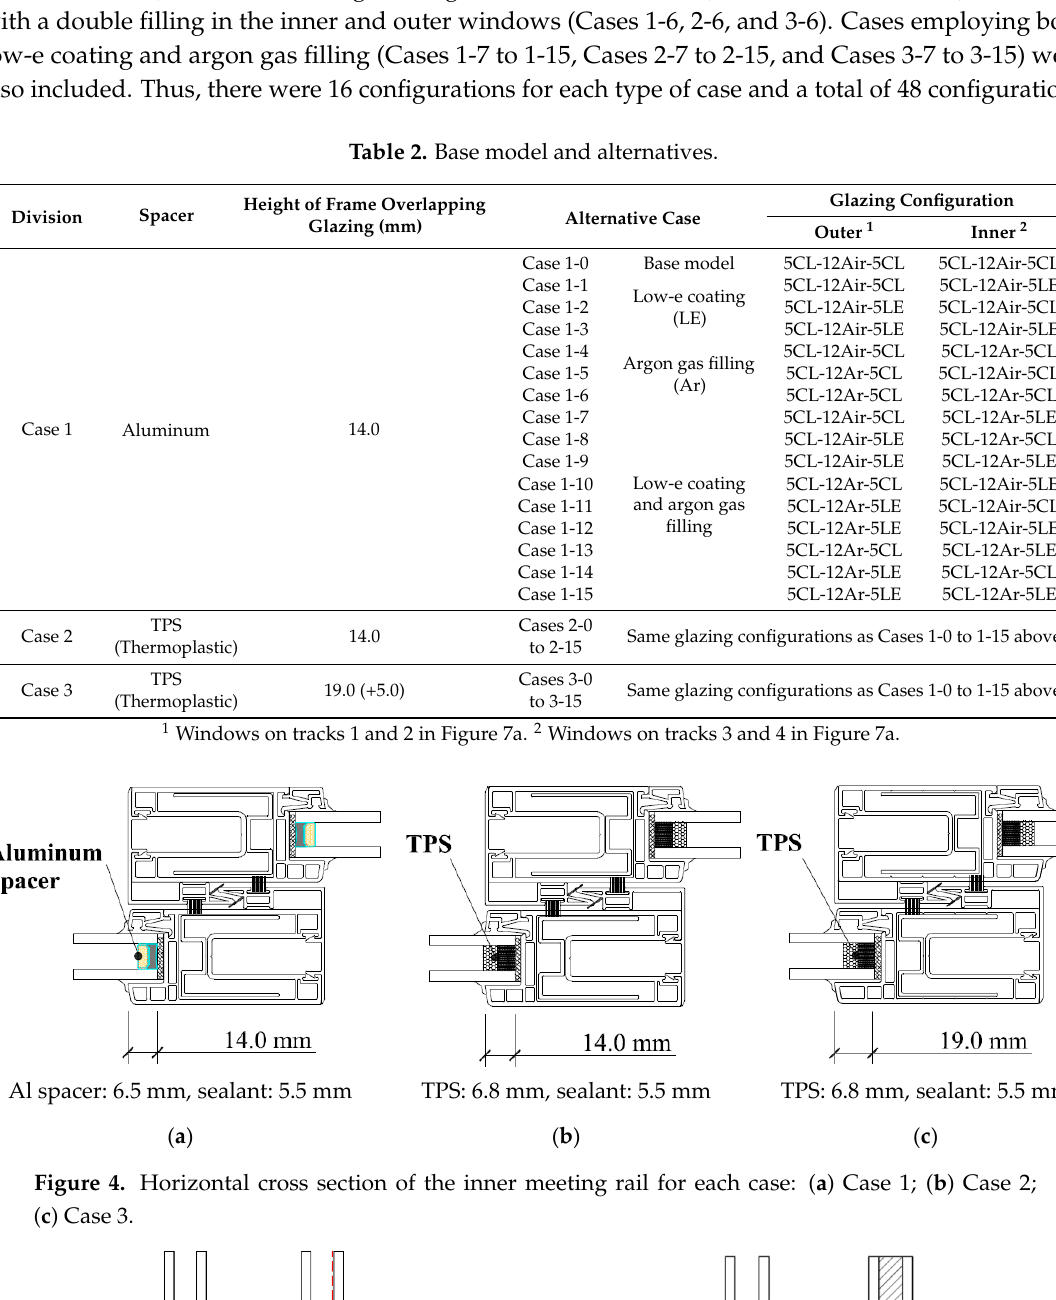
Table 2. Base model and alternatives.